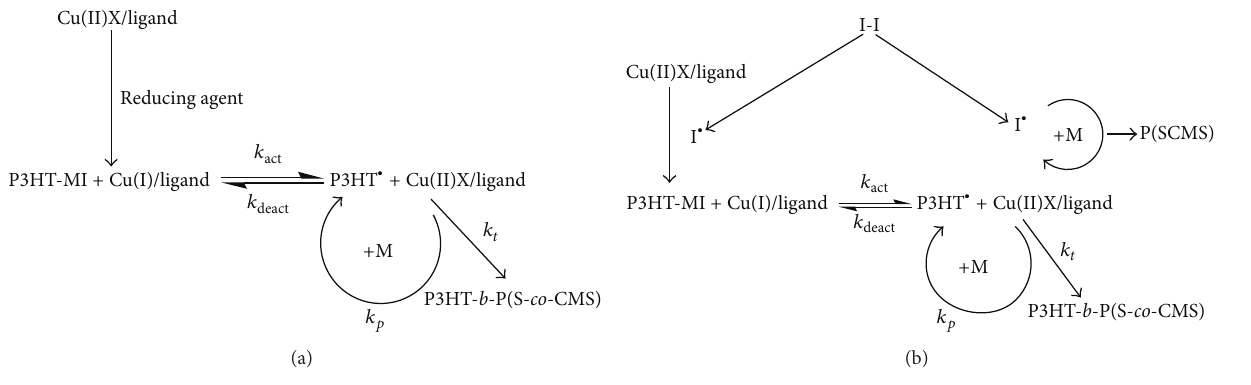
Figure 2: Mechanisms of (a) AGET-ATRP and (b) SR&NI